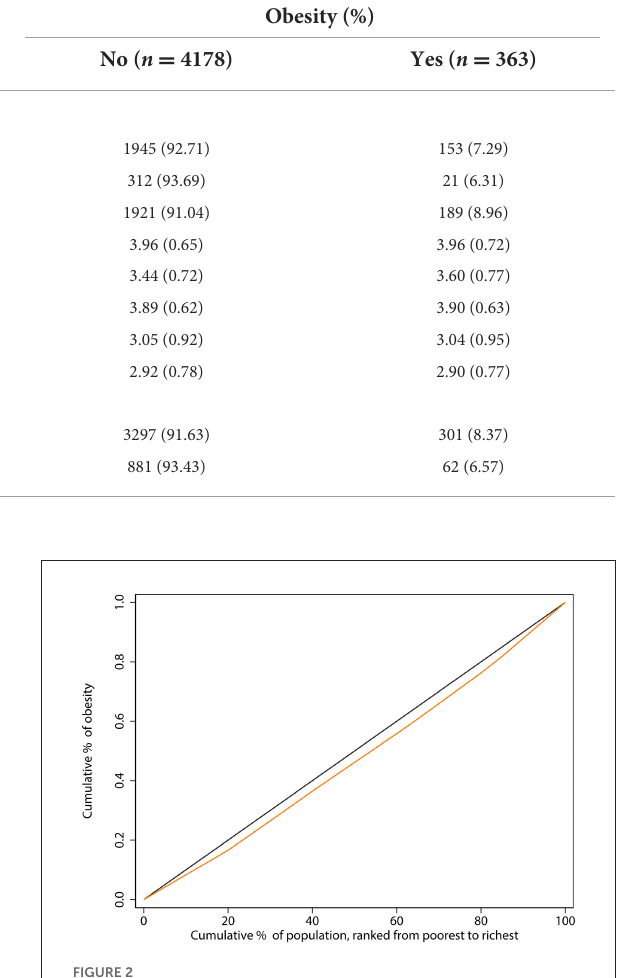
FIGURE2 Concentration curve of obesity among the elderly in China. The black line, running from the lower-left corner to the upper-right corner, is the equality line. The orange line below the equality line represents the concentration